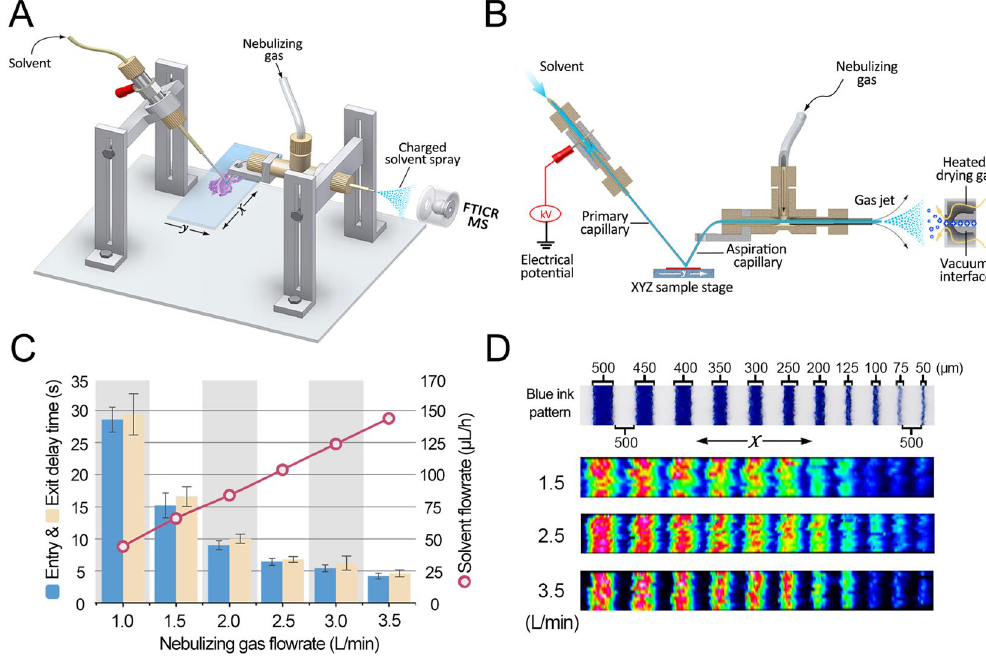
Figure 1. Experimental setup and the optimization of nebulizing gas flowrate and extracted solvent flowrate of the LE-ESSI. ( A ) 3D view schematic representation of the LE-ESSI device. ( B ) Schematic diagram of LE-ESSI MSI. ( C ) The entry & exit delay time of the extracted analytes when liquid bridge was located into or out off of the blue ink band at different nebulizing gas flowrate and different solvent flowrate. ( D ) Optical images and ion images of the blue ink patterns at different nebulizing gas